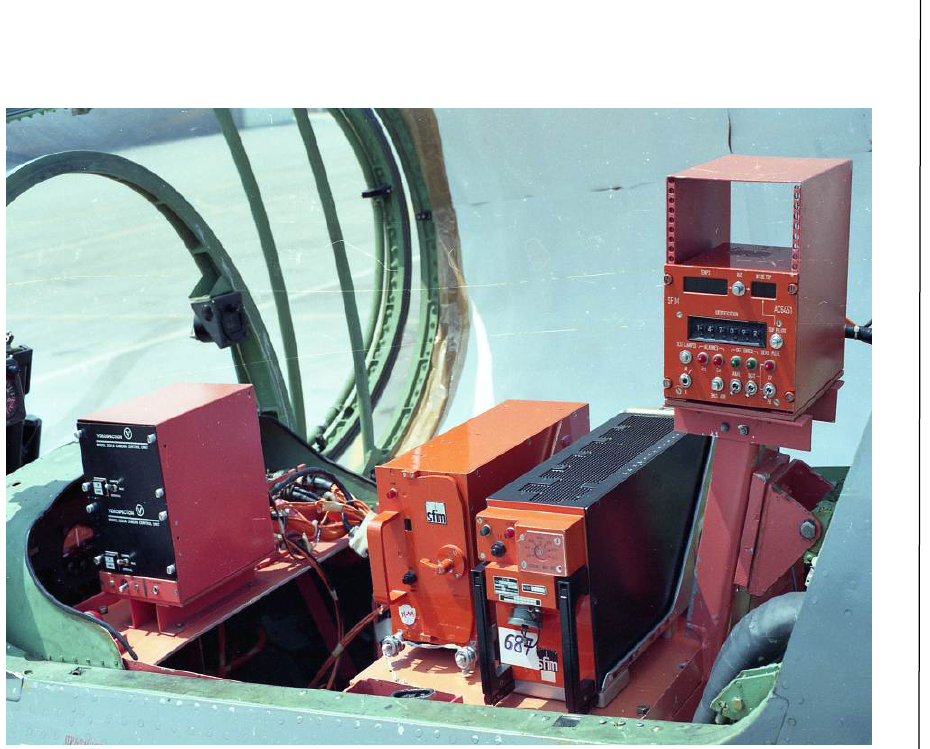
Figure 9 – D -V/SFIM embedded in the cabin of a prototype of the G-4 P-2 aircraft Super Galeb (Arhiv Vazduhoplovnog opitnog centra, 2016) Рисунок 9 –  D-V/SFIM" установленный в кабине прототипа самолета Г -4 П -2  Супер Галеб " (Arhiv Vazduhoplovnog opitnog centra, 2016) Слика 9 – D-V/SFIM уграђен у кабини прототипа авиона Г -4 П -2 „ супергалеб ”